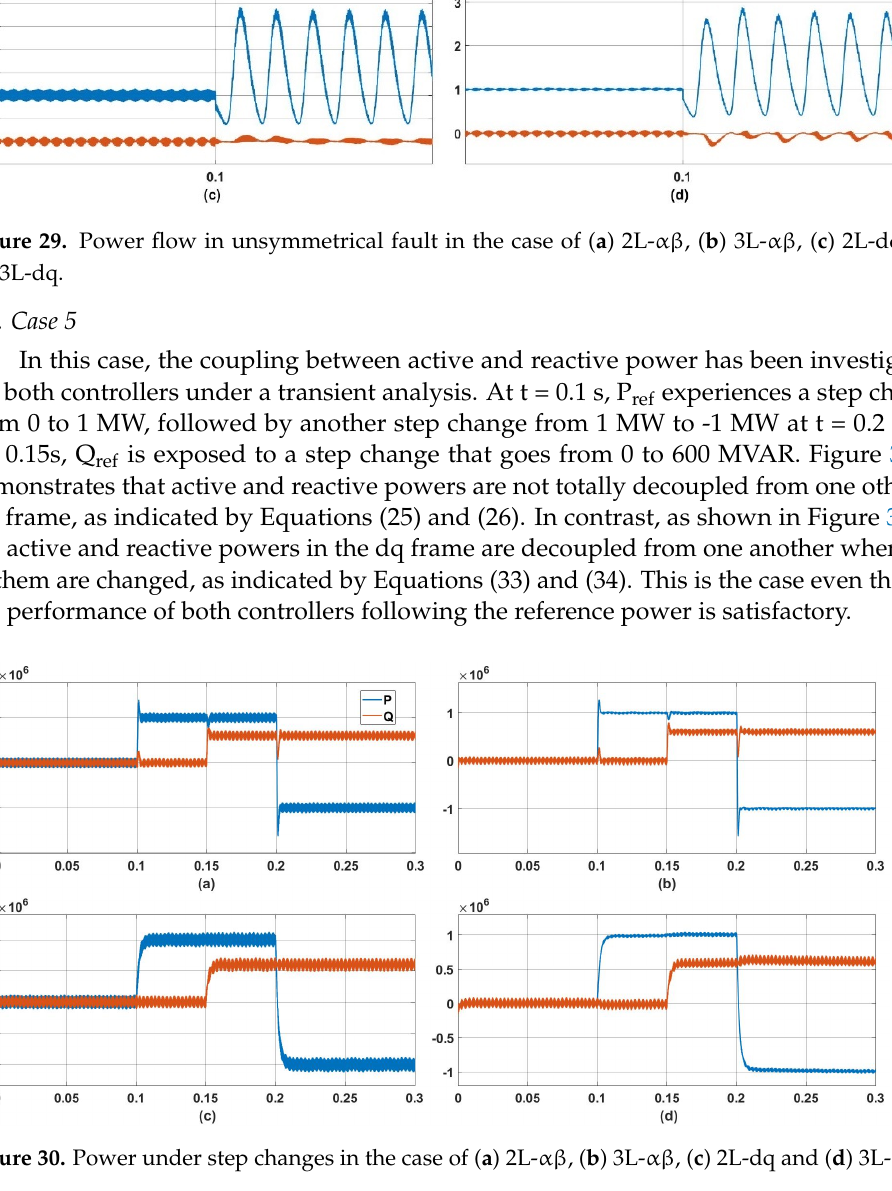
Figure 29. Power flow in unsymmetrical fault in the case of ( a ) 2L- αβ , ( b ) 3L- αβ , ( c ) 2L-dq and ( d ) 3L-dq.